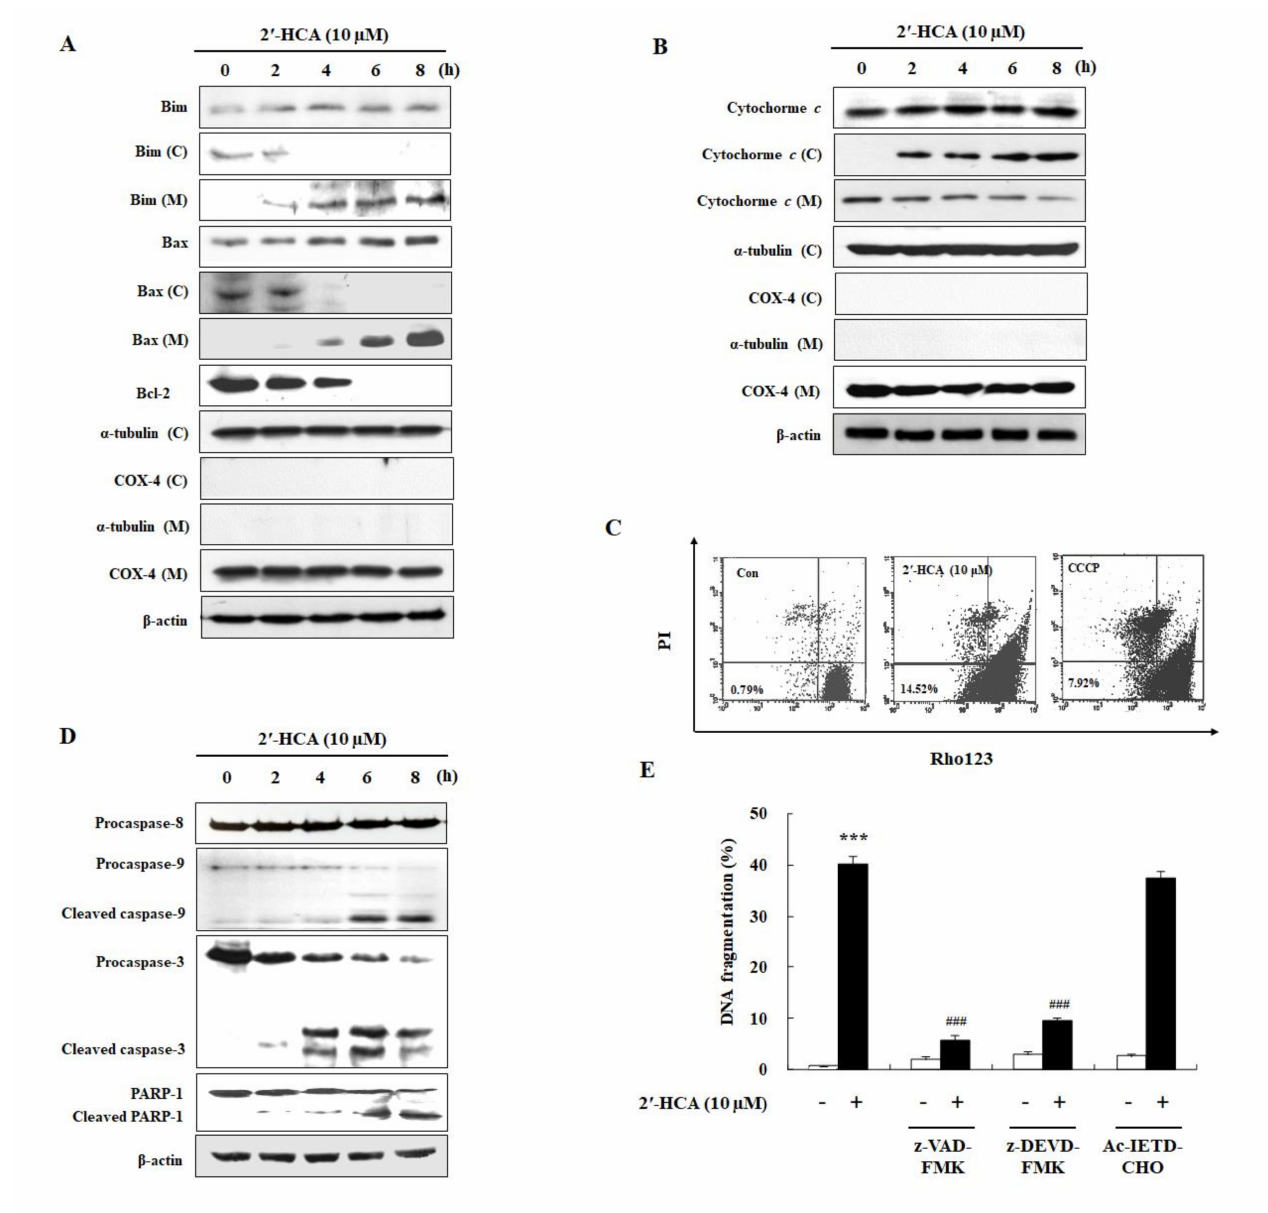
Figure 4. Effects of 2 (cid:48) -HCA on mitochondrial dysfunction and caspase activation in HL-60 cells. ( A , B ) Representative western blots showing changes in the protein levels of Bim, Bax, Bcl-2, and cytochrome c after treatment with 10 µ M 2 (cid:48) -HCA for the indicated times in HL-60 cells (C: cytosol, M: mitochondria). A-tubulin, COX 4, and β -actin were used as internal controls. ( C ) HL-60 cells were treated with 10 µ M 2 (cid:48) -HCA for 1 h, and ∆Ψ m was determined using rhodamine 123 and PI by flow cytometry. ( D ) Representative western blots showing changes in the protein levels of procaspase-9, procaspase-3, cleaved caspase-3, PARP-1, and cleaved PARP-1 after incubation with 10 µ M 2 (cid:48) -HCA for the indicated times in HL-60 cells. β -actin was used as an internal control. ( E ) HL-60 cells were pretreated with or without caspase inhibitors (50 µ M z-VAD-FMK, 50 µ M z-DEVD-FMK, or 50 µ M Ac-IETD-CHO) for 1 h and treated with 10 µ M 2 (cid:48) -HCA for 8 h. The extent (%) of DNA fragmentation was determined by DAPI assay as described in the Section 2. Data are presented as the mean ± SD of three independent experiments. *** p < 0.001 vs. control group, ### p < 0.001 vs. 2 (cid:48) -HCA-treated